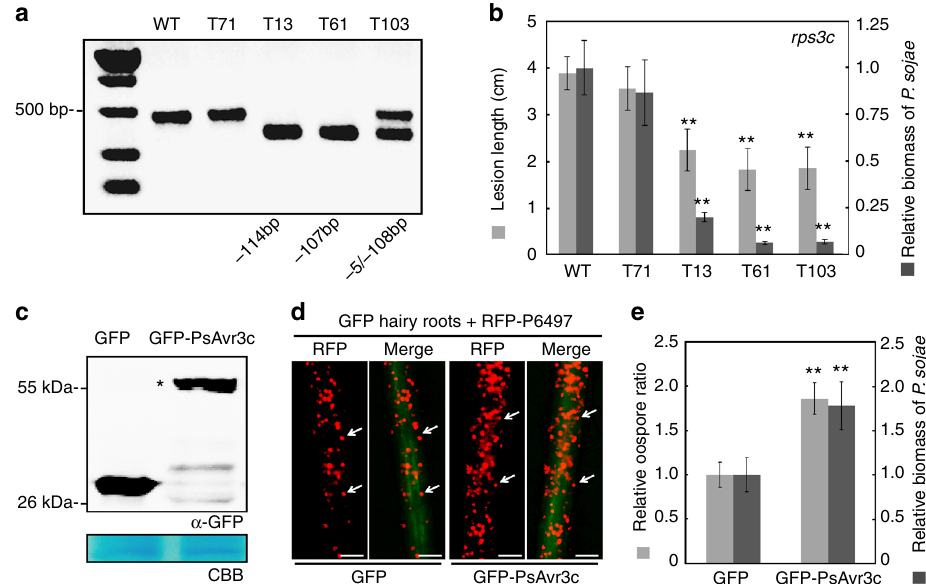
Fig. 1 Effector gene PsAvr3c is required for full virulence of P . sojae . a Knockout PsAvr3c gene by CRISPR/Cas9. The agarose gel shows a PCR result of PsAvr3c loci from individual P . sojae mutants. Mutants T13 and T61 are homozygous, whereas T103 is a heterozygote. WT represents wild-type P . sojae strain P6497. The line T71 is a transformant without PsAvr3c editing events. b Measurements of lesion lengths and relative biomass on susceptible soybean ( rps3c ). Means and standard errors of lesion lengths from six replicates are shown in light gray (** P < 0.01; one-way ANOVA). For relative biomass quanti fi cation, the ratio of P . sojae DNA compared with soybean DNA was measured at 48 hpi. Means and standard errors of biomass from three replicates are shown in dark gray (** P < 0.01; one-way ANOVA). c Immuno-blot analysis of GFP-PsAvr3c and GFP in soybean ( rps3c ) hairy roots. The position of GFP-PsAvr3c protein band is indicated by asterisk. The loading control gel was stained with Coomassie brilliant blue (CBB) to visualize